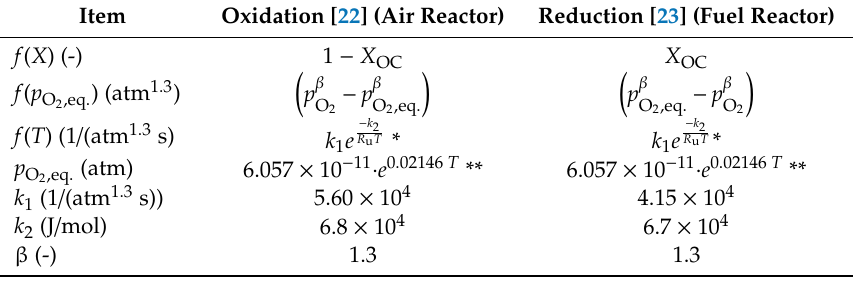
Figure 1. Equilibrium partial pressure of oxygen over the CuO / Cu 2 O system. Table 1. Functions and constant parameters of oxygen carrier oxidation and reduction